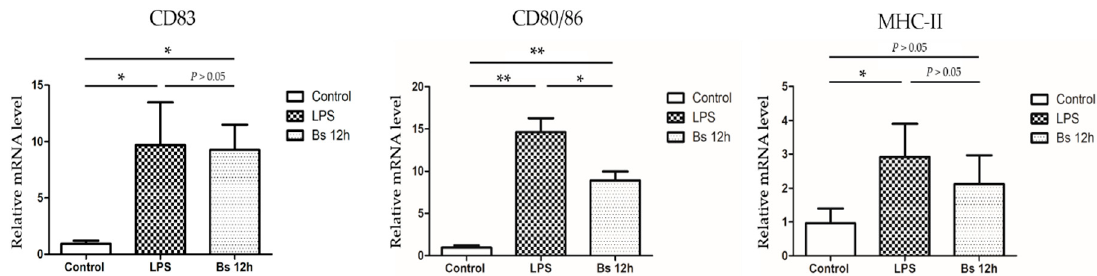
Figure 4. Changes in the expression of functional molecular markers ( CD83 , CD80/86 , and MHC II ) in dendritic cells under lipopolysaccharide (LPS) or Bacillus subtilis stimulation. The mRNA levels measured by quantitative polymerase chain reaction (qPCR) are presented as the relative fold change normalized against the housekeeping β -actin gene. All the three independent experiments had the same trend on functional molecules by quantitative real-time PCR (qRT-PCR). Data are expressed as mean ± SD ( n = 3). * p < 0.05 and ** p < 0.01 indicate statistically significant differences as compared with the control group.